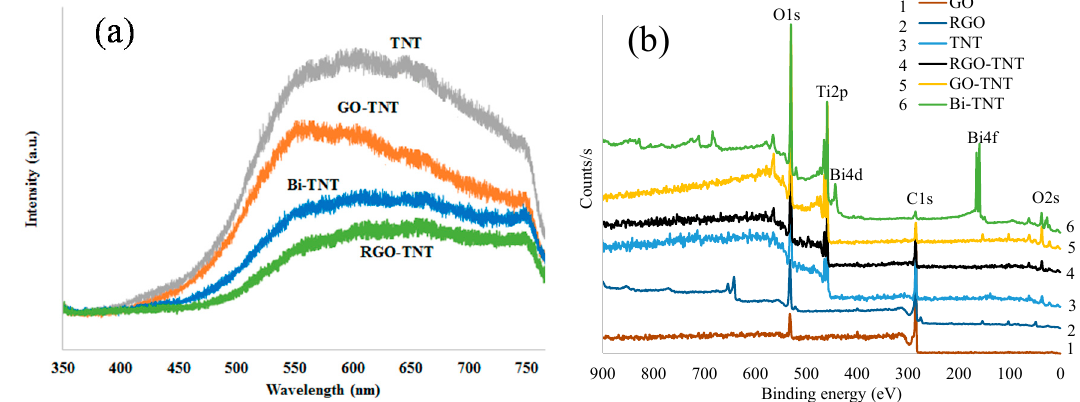
Figure 4. ( a) PL spectra; ( b ) XPS full spectrum of TNTs, RGO ‐ TNTs, Bi ‐ TNTs, and GO ‐ TNTs.